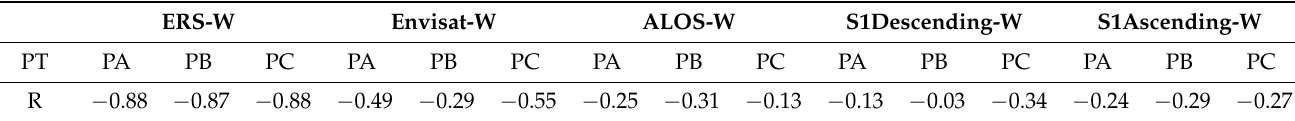
Table 2. Relationship between InSAR deformation displacement and water level. The correlation coefficients (R) between water level (W) and InSAR displacement for each sensor (ERS, Envisat, ALOS, S1D, S1A), 500 m from the shoreline in each transect (PT: PA, PB, and PC, respectively).